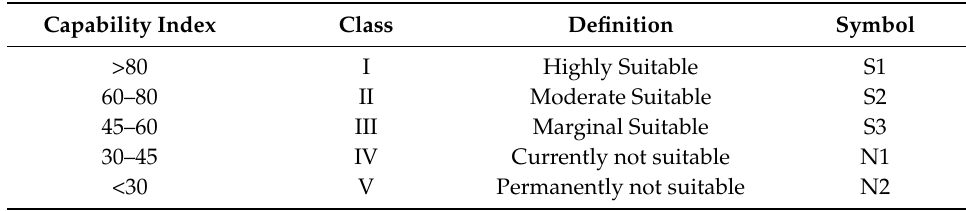
Table 2. Suitability index for the irrigation capability indices (Ci) classes [30].